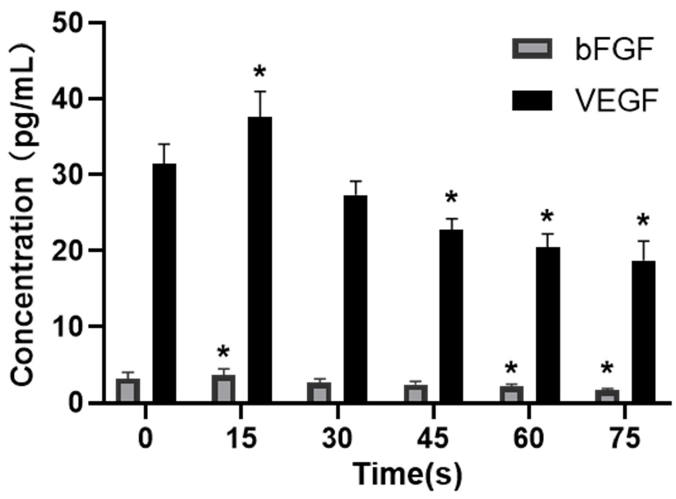
Figure 6. Effects of PAM on secretion of VEGF and bFGF, * compared with control group p < 0.05.